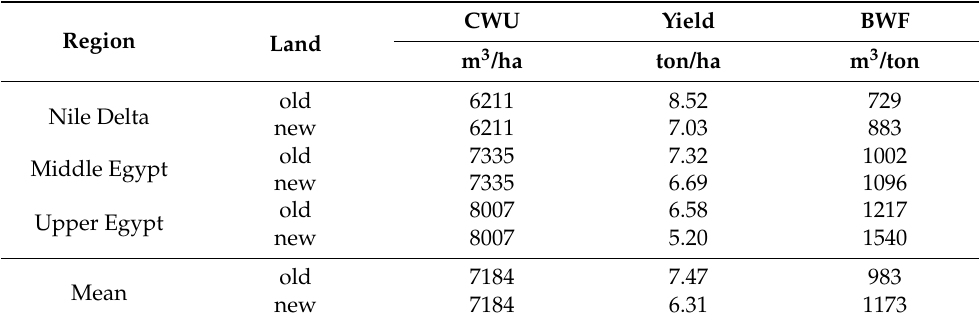
Table 4. Crop water use (CWU m 3 /ha), maize yield (ton/ha), and blue water footprint for different climate regions in old and new